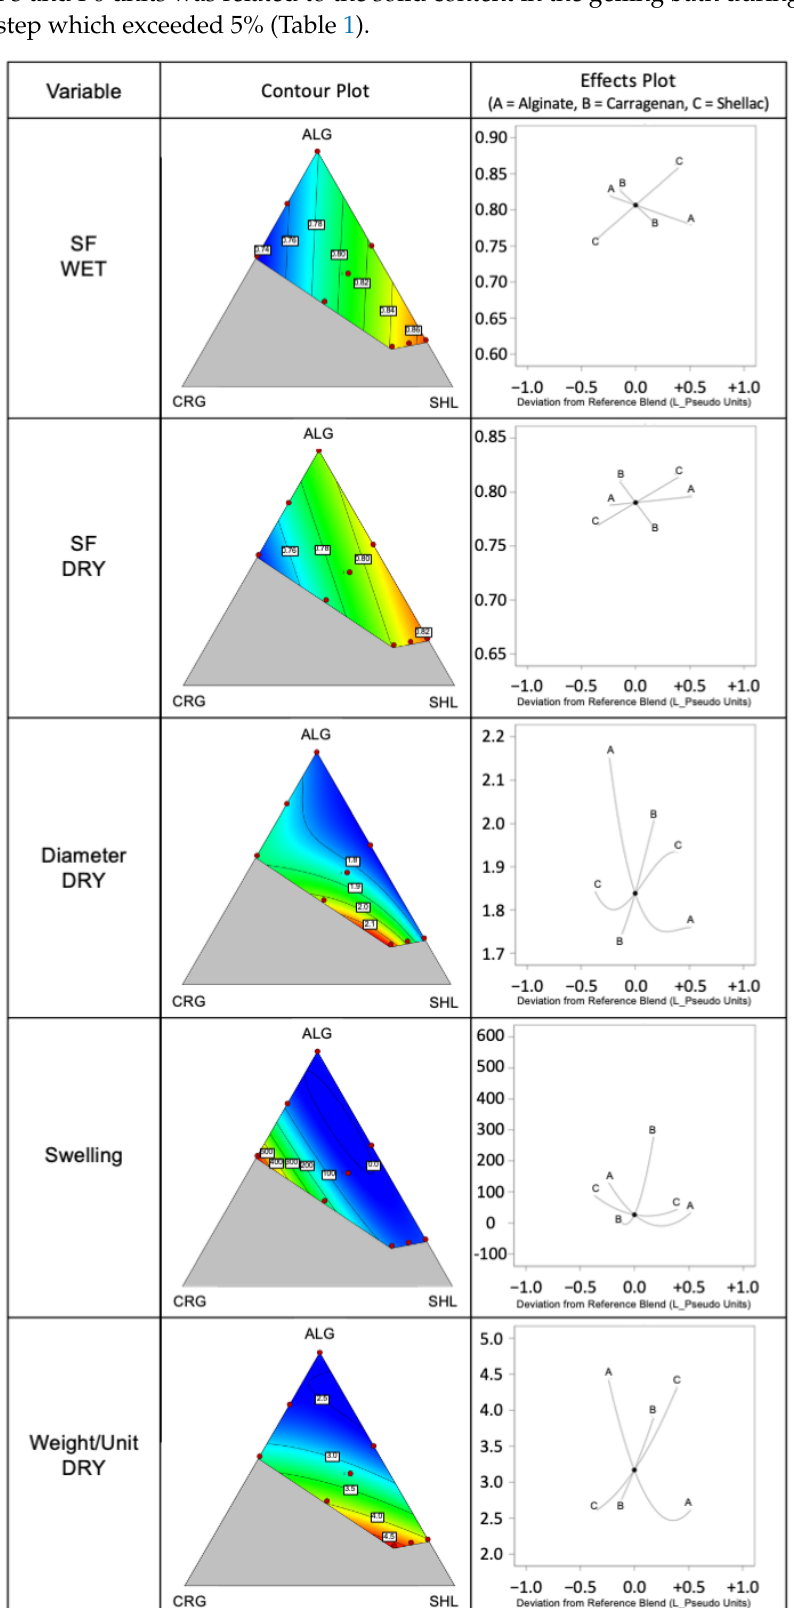
Figure 3. Contour plots and effect plots of significative models.